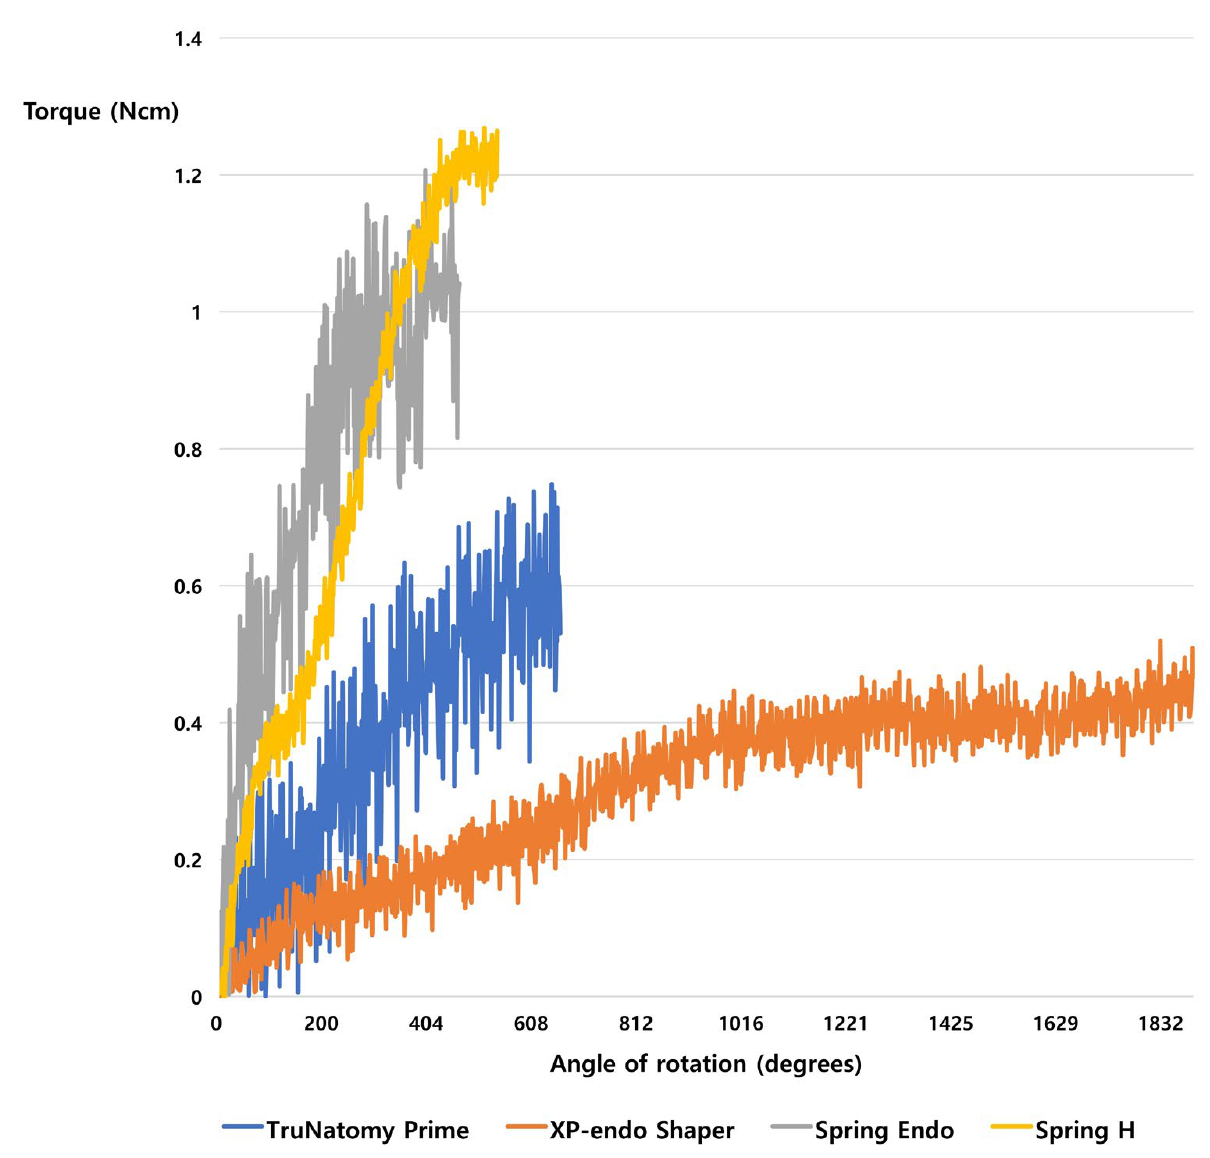
Figure 2. Representative torque–angle of rotation curves of the tested files based on the torsional resistance test results.